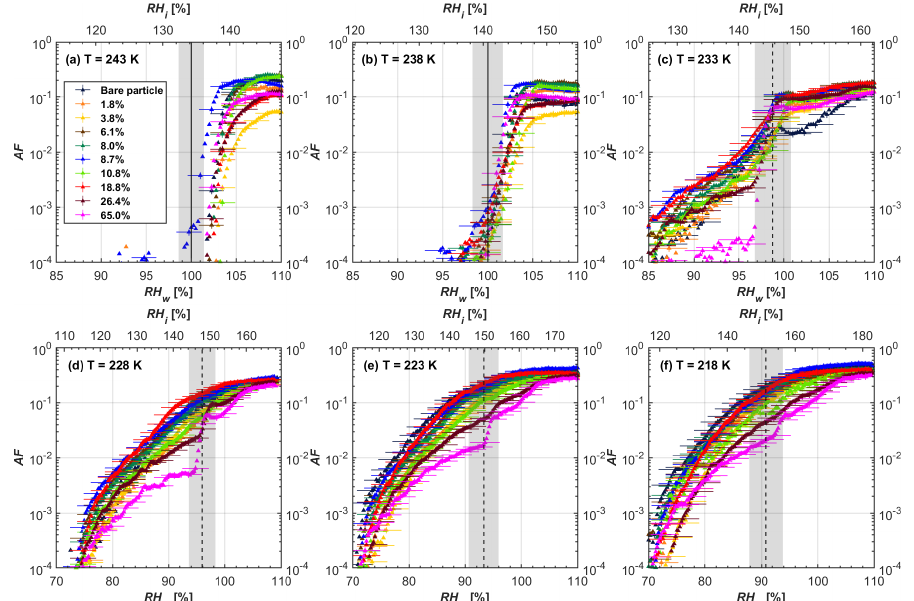
Figure B4. RH scans for bare and coated 400nm FW200 soot particles at nine different coating wt% corresponding to the 1µm OPC channel, presented as AF as a function of RH. Black solid lines represent water saturation conditions according to Murphy and Koop (2005). Black dashed lines denote the expected RH values for homogeneous freezing at T < HNT (Koop et al., 2000). The grey-shaded areas show the possible RH uncertainty calculated for water saturation and homogeneous freezing conditions. The percentage number represents the H 2 SO 4 coating mass ratio to the bare particle